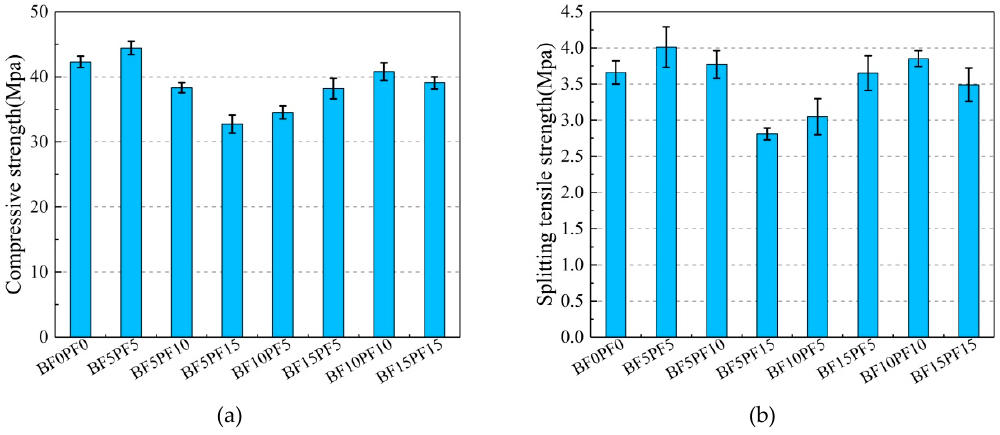
Figure 3. The compressive strength and splitting tensile strength of different mixtures. ( a ) Compressive strength. ( b ) Splitting tensile strength.